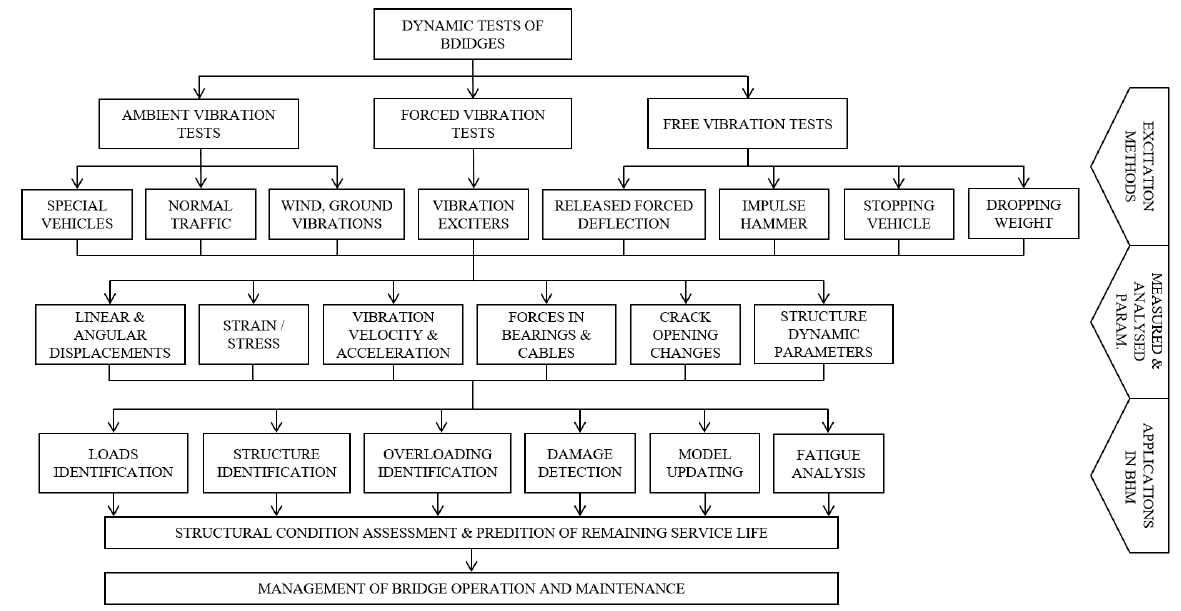
Figure 2. Classification of dynamic tests of bridge structures Figure 2: Classification of dynamic tests of bridge